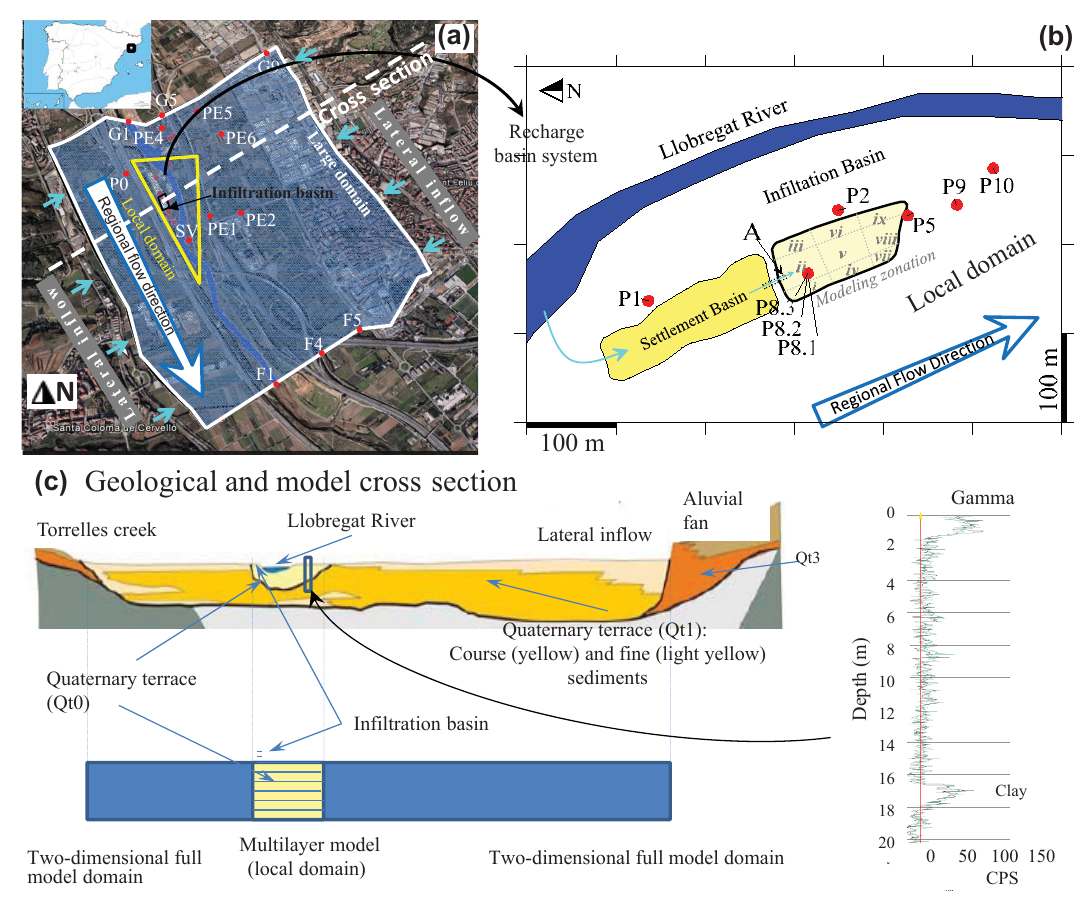
Figure 1. General (a) and local (b) plan views of the infiltration system, monitoring points, and model dimensions. (c) Geologic cross section of the site and the conceptualization used in the numerical model, and natural gamma measurements from the site. The area identified with the yellow triangle in (a) was modeled as a multilayer aquifer (see c